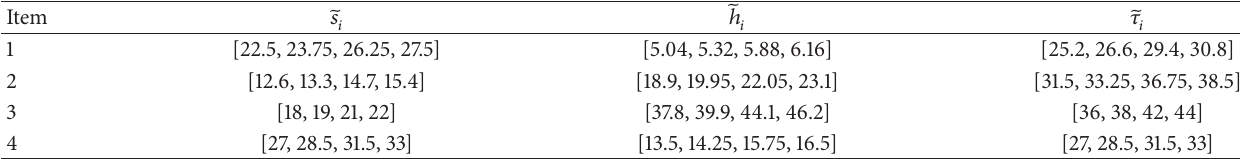
Table 7: The basic data under uncertainty.